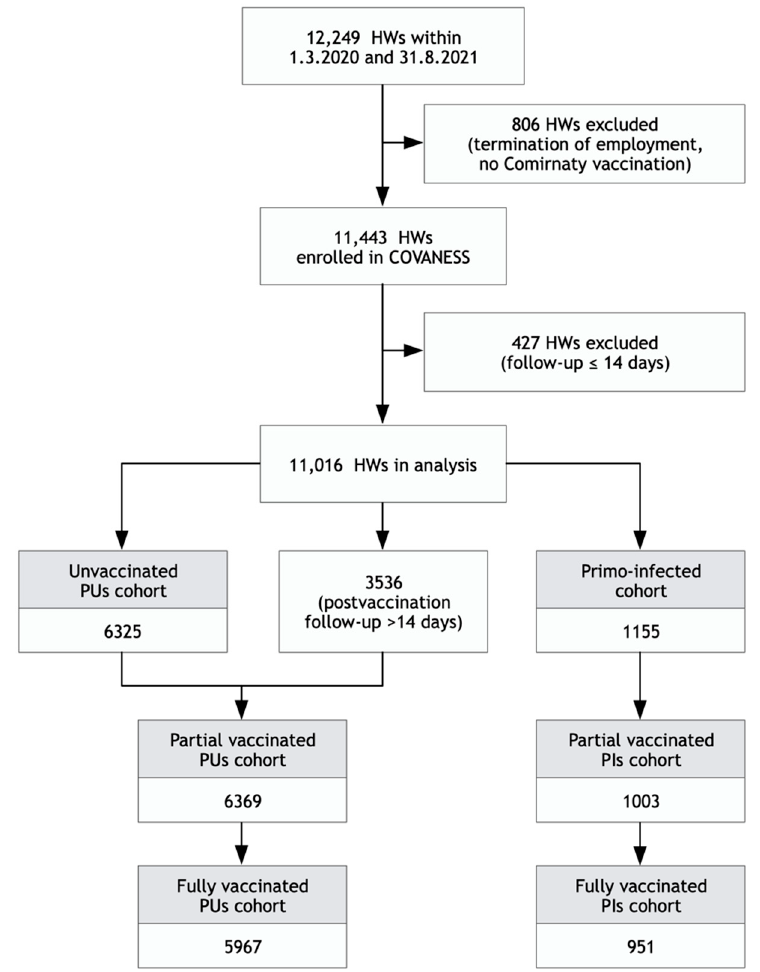
Figure 2. Study flowchart: HWs: hospital workers; PUs: previously uninfected; PIs: previously